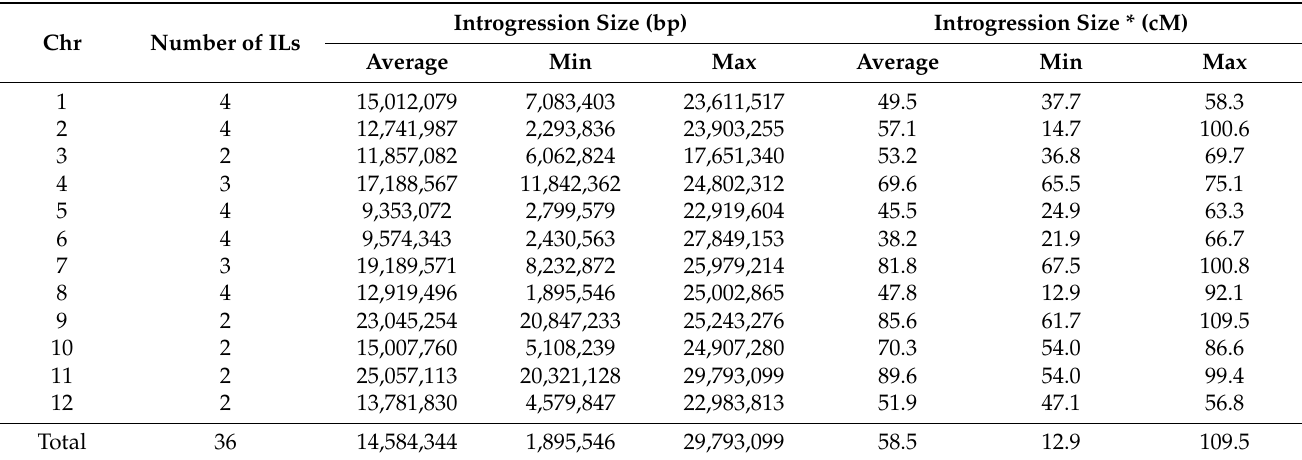
Table 1. Summary of the developed introgression lines population, with average introgression size per chromosome in physical and genetic distance.